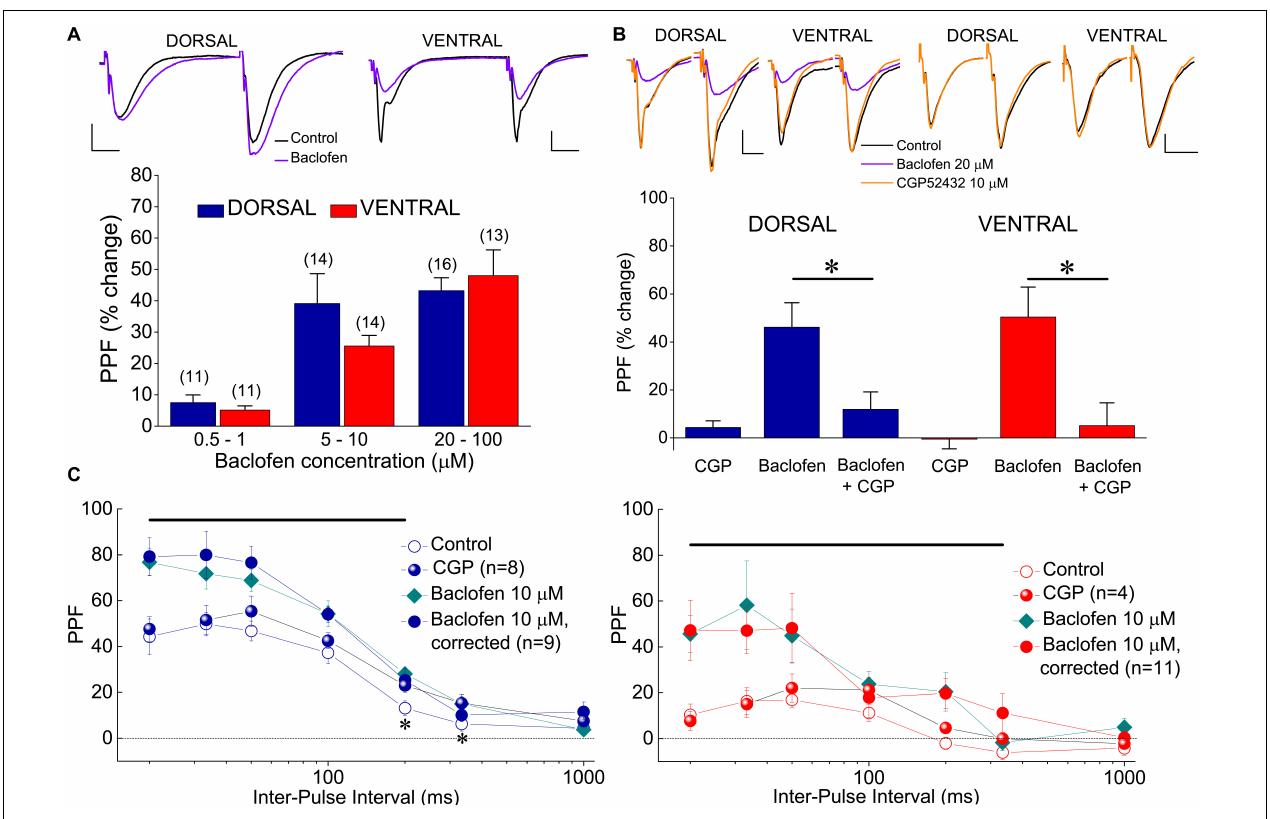
FIGURE 9 | Baclofen enhances PPF of fEPSP slope . (A) Cumulative data of the effects of various baclofen concentrations on PPF are shown for the dorsal and the ventral hippocampus; example traces obtained before (traces in black) and during application of 10 µ M baclofen (traces in violet) in a dorsal and a ventral slice are shown on the top of the graph. In the example of the dorsal hippocampus, similar unconditioned fEPSP slope under control and drug conditions were selected for comparison reasons. Drug concentrations are segregated into three groups: 0.5 − 1, 5 − 10, and 20–100 µ M. PPF is expressed as the percent change of the ratio fEPSP2/fEPSP1 observed under baclofen with respect to control conditions. The number of slices used in each condition is indicated into parenthesis on the top of each bar. Baclofen significantly increased PPF in both hippocampal segments (ANOVA, F = 4.8, p < 0.005 in dorsal and F = 5.6, p < 0.001 in ventral hippocampus). (B) The antagonist of GABA B R CGP52432 (10 µ M) reversed the increase of PPF induced by 20 µ M baclofen in four dorsal and four ventral slices (asterisks indicate statistically significant difference with respect to control values, at p < 0.05, paired t -test). Blockade of GABA B Rs under basal conditions did not significantly affect PPF in either dorsal ( n = 8) or ventral ( n = 4) hippocampal slices. In all cases PPF was induced at 50 ms. Respective examples are shown on the top of the graph. (C) PPF plotted as a function of IPI in dorsal (left) and ventral (right) under control conditions, application of CGP52432, and application of baclofen with or without adjustment of fEPSP slope to control levels. Horizontal bars denote statistically significant differences between control and baclofen-corrected conditions (paired t -test, p < 0.05). Also, asterisks in the left graph indicate that application CGP52432 significantly increased PPF in dorsal